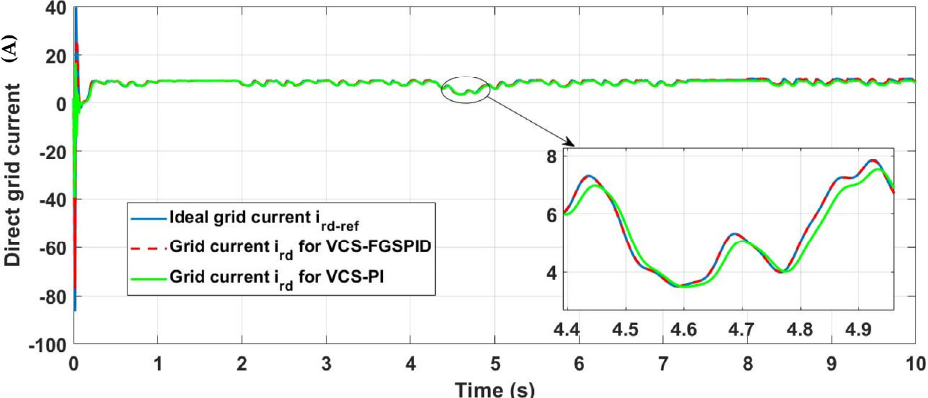
Figure 39. Hardware co-simulation for direct grid current.